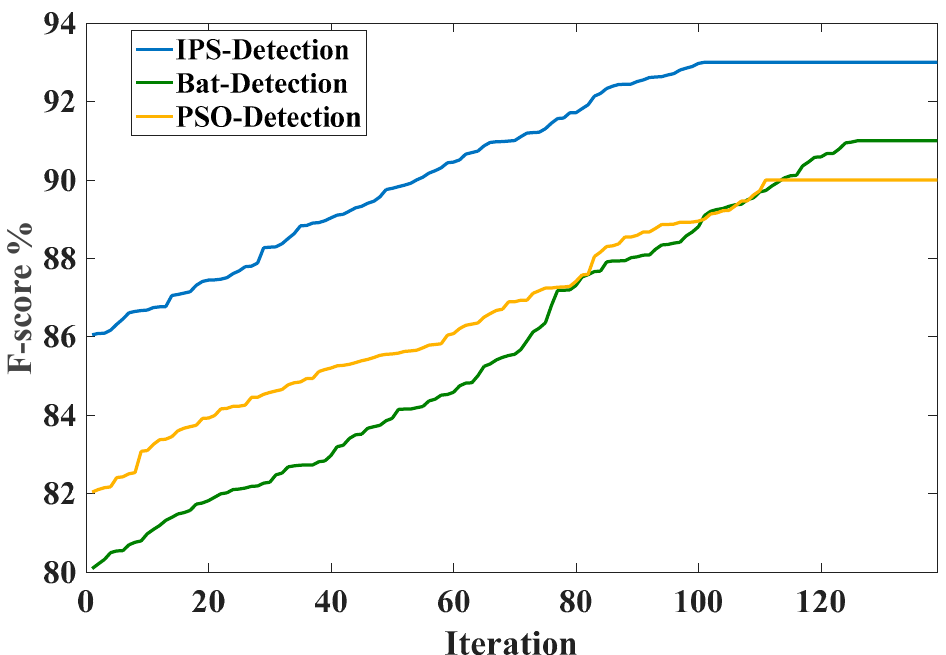
Figure 8. Illustration of the energy consumption deviations for different 𝛼.